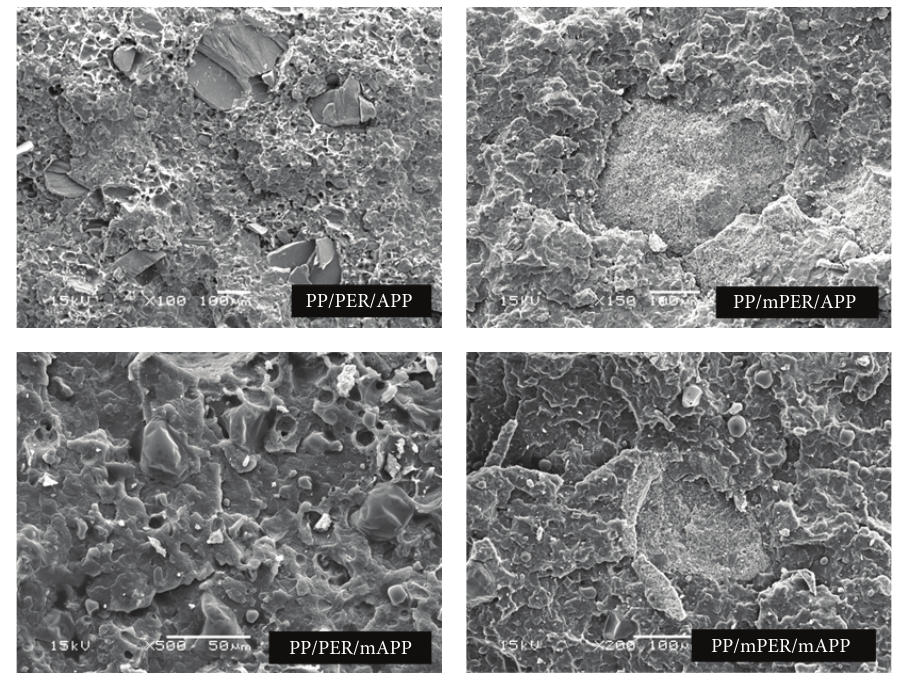
Figure 7: SEM images taken of the fracture surfaces of the intumescent flame retarded PP